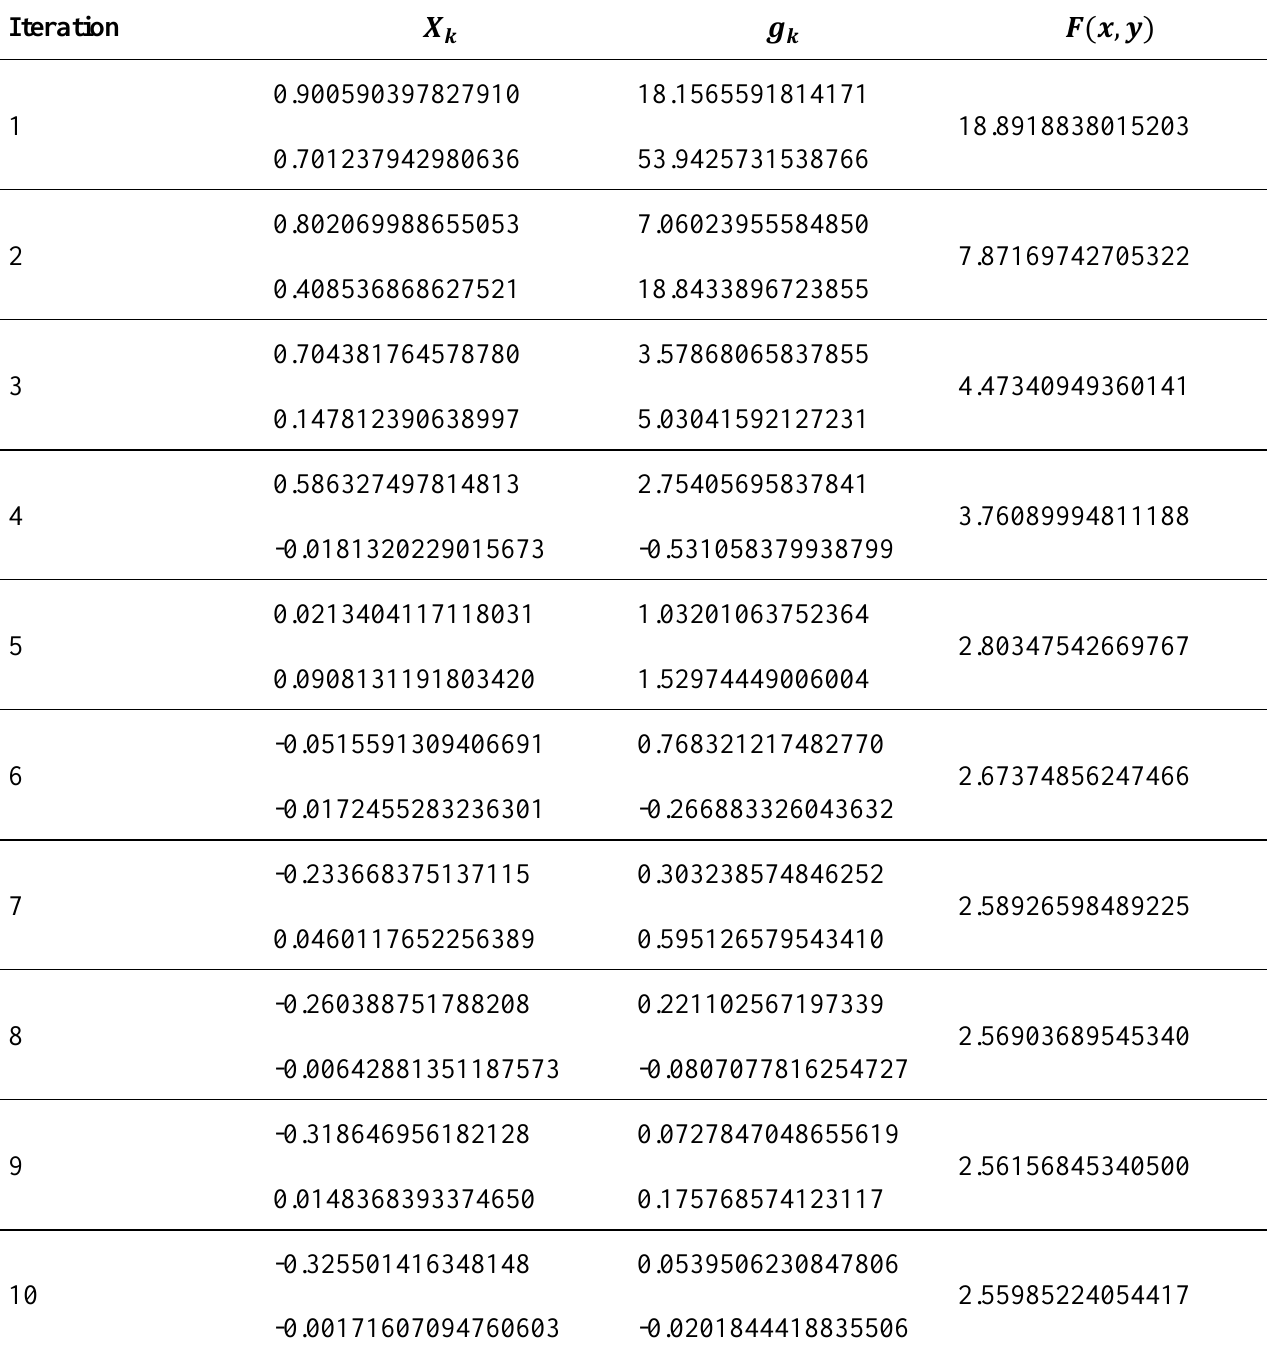
Table 4 Results obtained for the problem in Example 2. by using the Steepest descent method